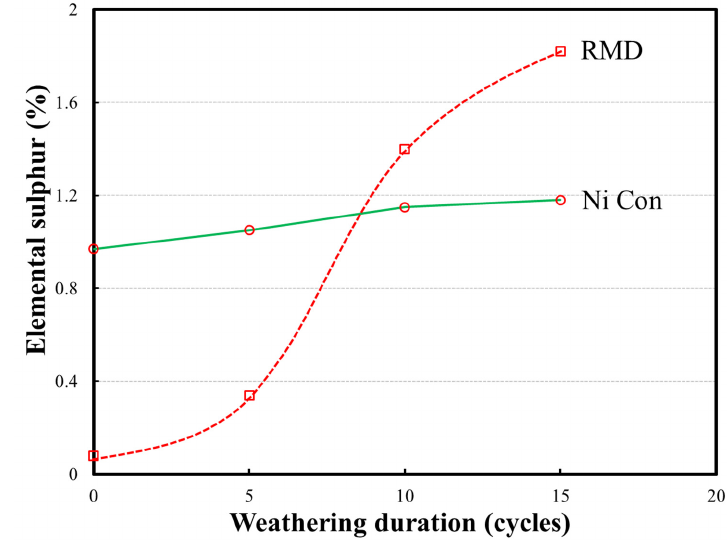
Figure 6. Effect of weathering on the generation of elemental sulphur: RMD and Ni Con samples. Figure 6. E ff ect of weathering on the generation of elemental sulphur: RMD and Ni Con